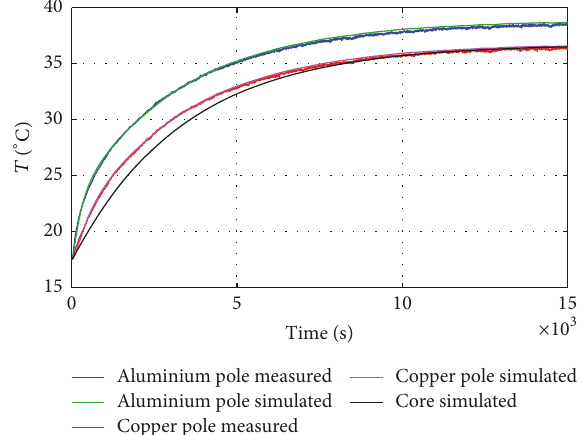
Figure 9: Model output and system output comparison for 1st set of measurements with tuned parameters.